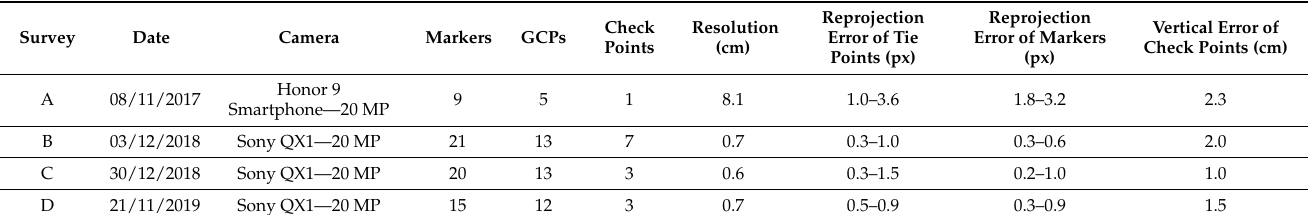
Table 1. Characteristics of the cameras (resolution), the markers (number) and the accuracy of the four 3D models obtained from the photogrammetric